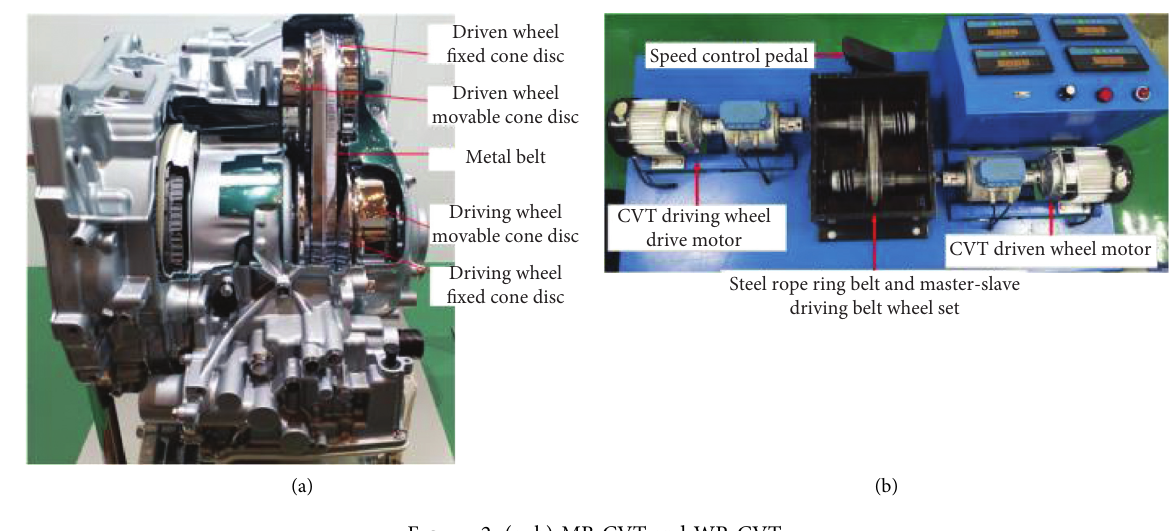
Figure 2: (a, b) MB-CVT and WR-CVT.